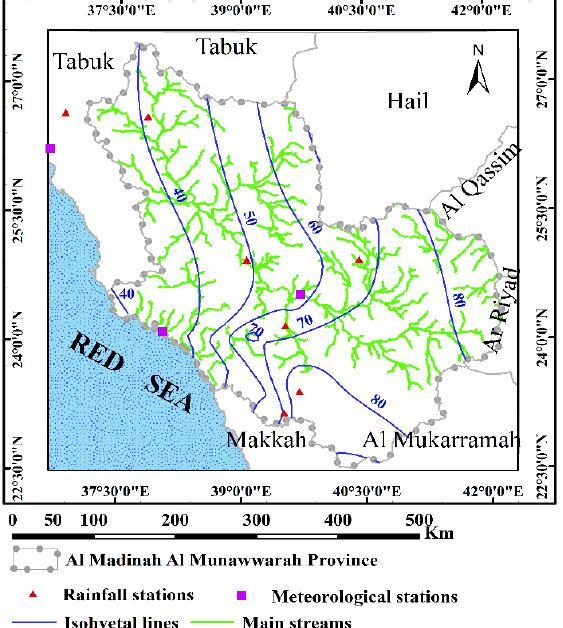
Figure 3. Isohyetal map of Al Madinah Al Munawarah Province based on the annual mean for a 48 ‐ year duration.